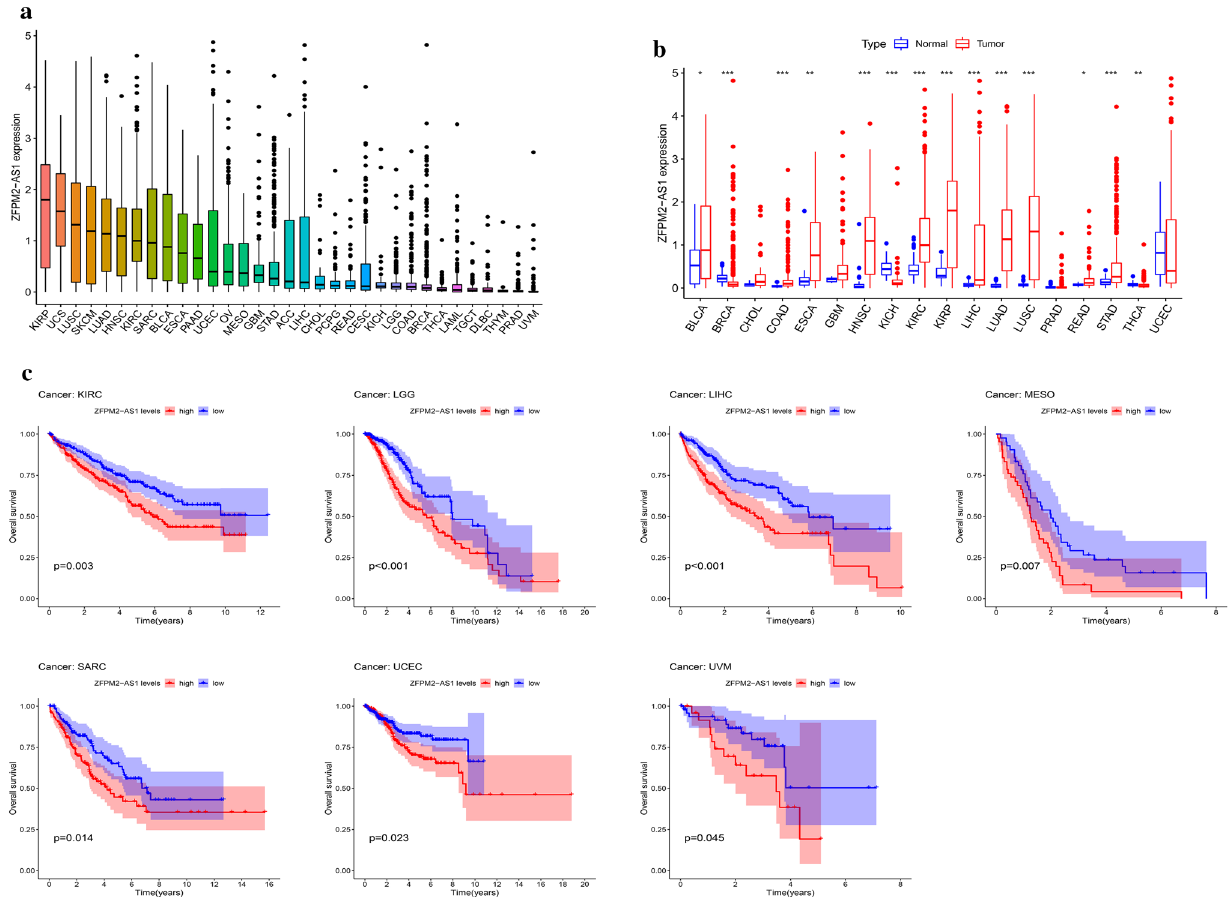
Fig. 4 Expression analysis and survival analysis of ZFPM2-AS1 in pan-cancers. a Expression level of ZFPM2-AS1 in pan-cancers. b Differential expression of ZFPM2-AS1 in pan-cancers. c The survival curve of ZFPM2-AS1 for OS in pan-cancers. * P < 0.05, ** P < 0.01, *** P <